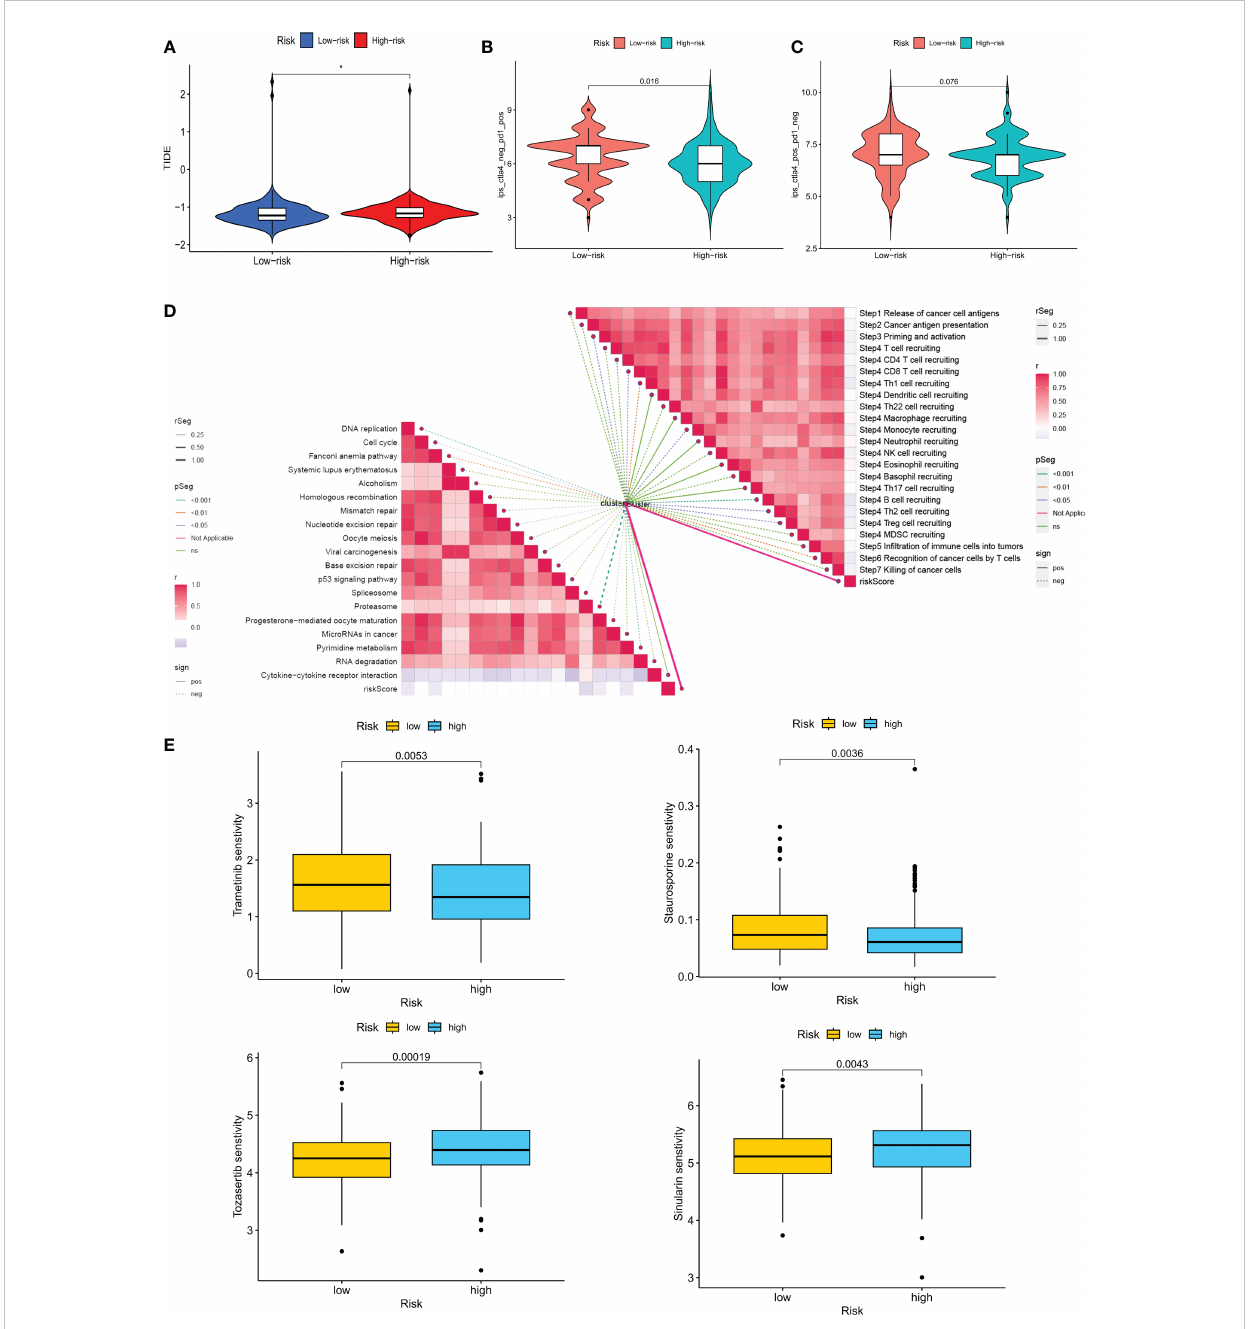
FIGURE 10 Analysis of treatment outcomes between the high-risk and low-risk groups. (A) TIDE analysis between the high-risk and low-risk groups. (B, C) Comparison of the relative distribution of immune scores (IPS) between the high-risk and low-risk groups. (D) Correlation of risk scores with ICB response characteristics and each step of the tumor-immune cycle. (E) Sensitivity to Tozasertib, Staurosporine, Trametinib, and Sinularin in the high- risk and low-risk groups. *p <